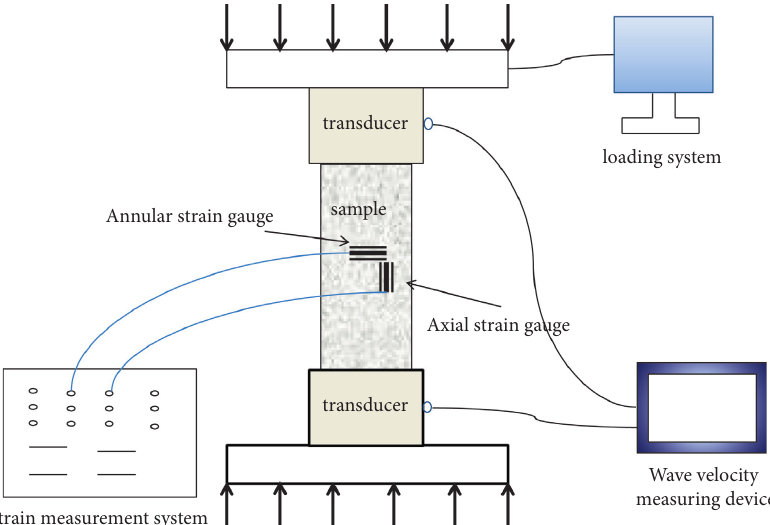
Figure 5: Longitudinal wave velocity test during